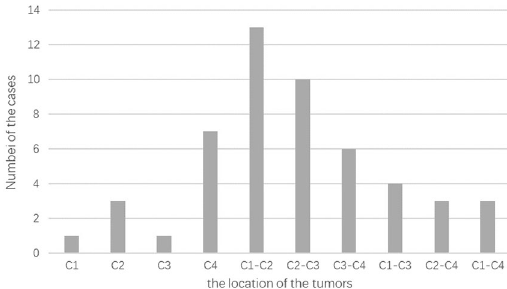
Figure 1. The distribution of tumors according to the location.